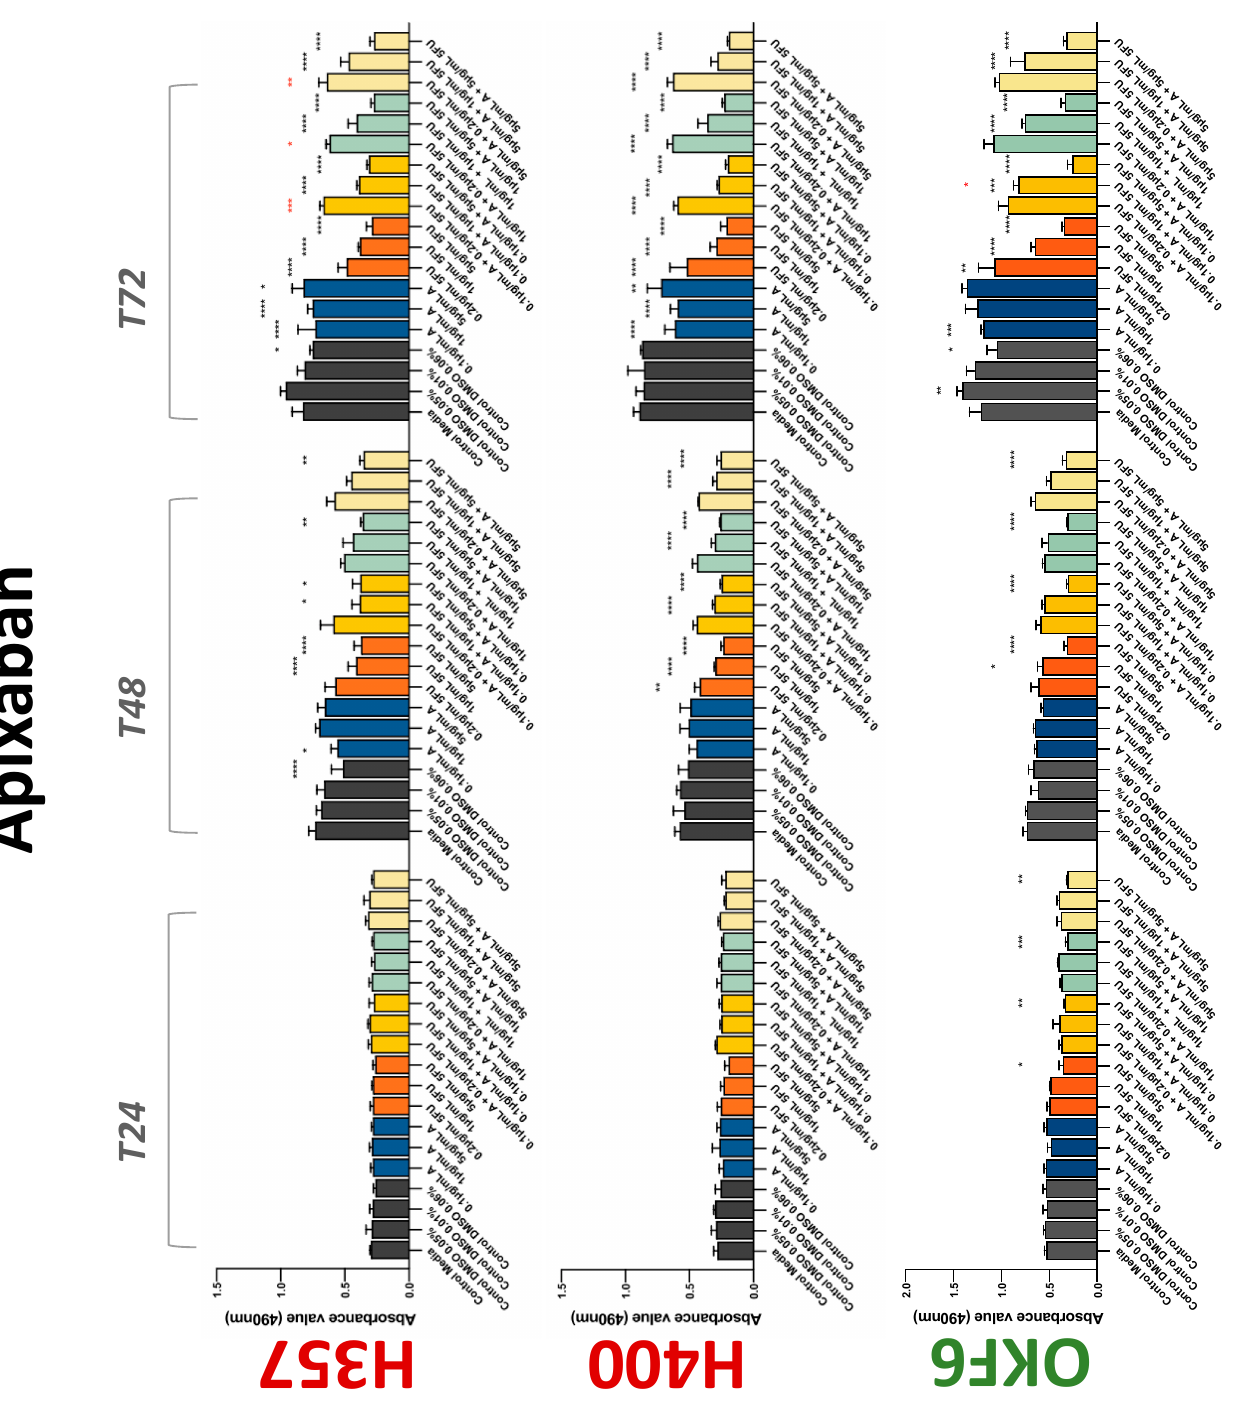
Figure 4. MTS assay . The effect of (0.1/1/5 μ g/mL) apixaban and (0.2/1/5/10 μ g/mL) 5-FU on H357, H400, and OKF6 cell proliferation. Data are represented as mean ± SD. Statistical significance is given as follows: * p < 0.05, ** p < 0.01, *** p < 0.005, **** p < 0.001; * (black) compared to control group; * (red) compared to respective 5 - FU groups.